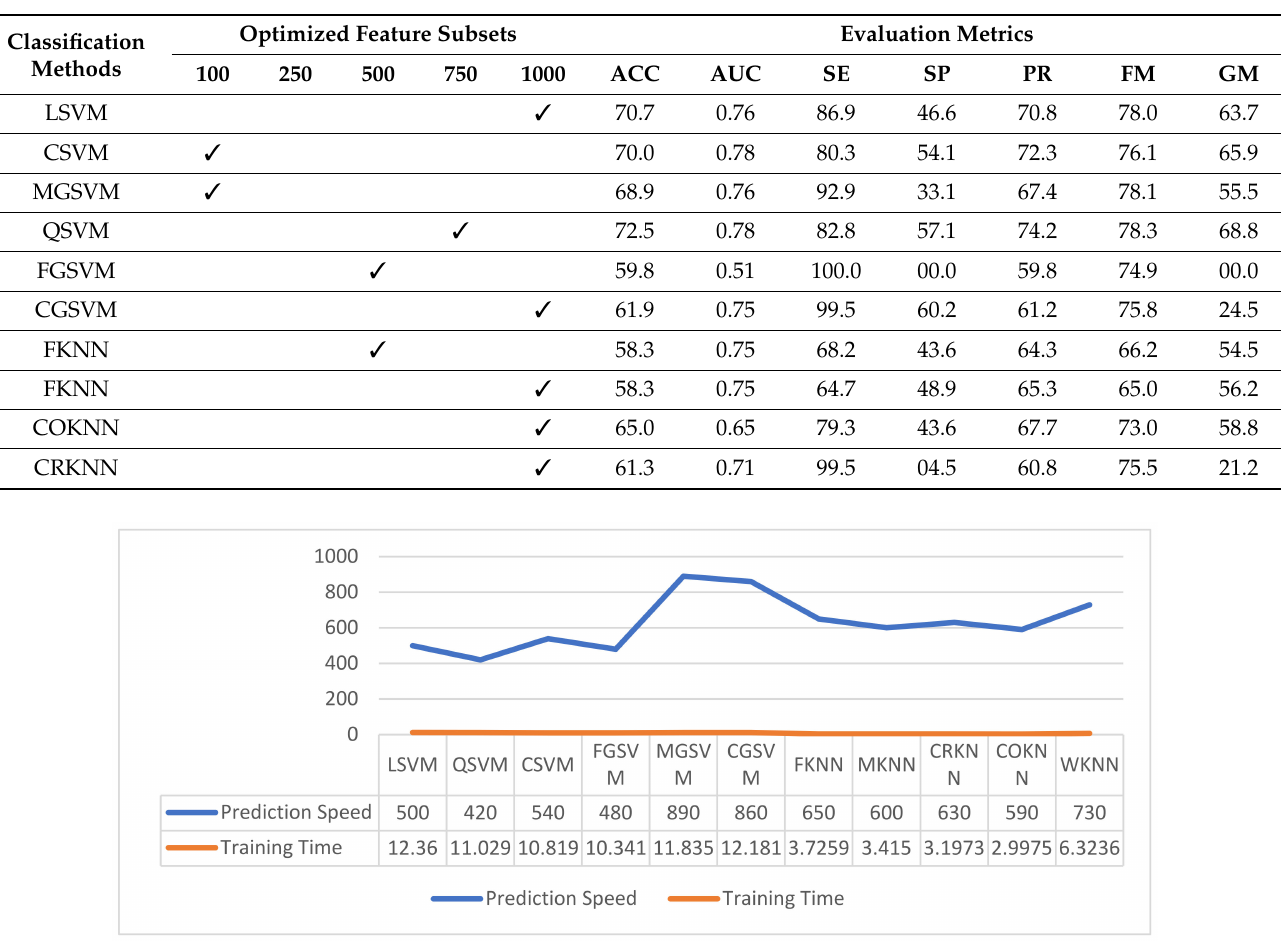
Table 10. Back view-based experimental results on VIPeR dataset.